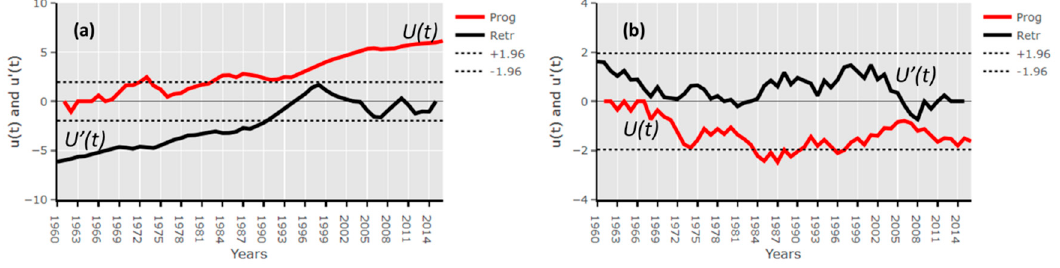
Figure 6. Sequential Mann-Kendal statistic values of progressive u(t) (solid redline) and retrograde u’(t) (black solid line), obtained by Sequential Mann-Kendall test for temperature ( a ) and rainfall ( b ) of Conakry airport: 1960–2016.